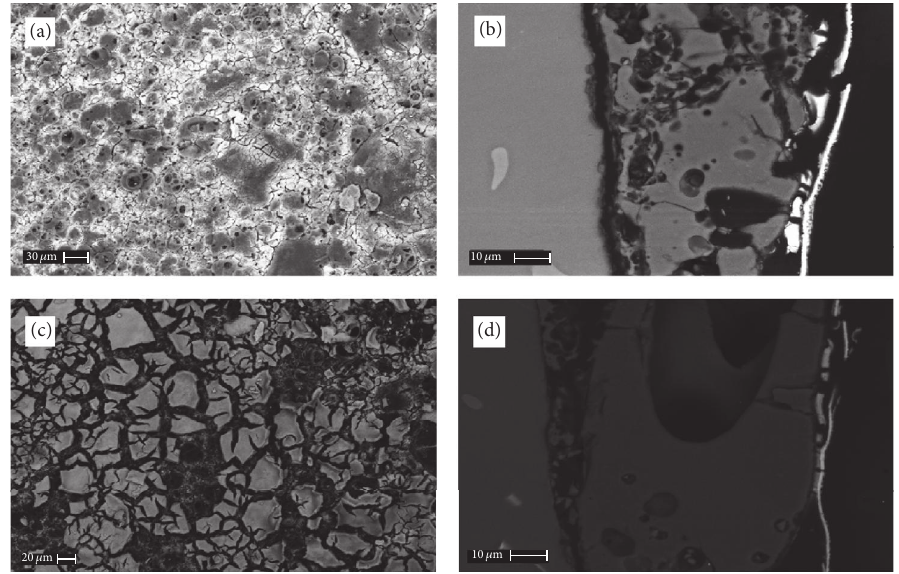
Figure 9: Scanning electron micrographs (backscattered electrons) of the surface and cross section of sealing coatings formed on AZ91 magnesium alloy with 12 g/l of La(NO 3 ) 3 at 40 ∘ C for 10 minutes (a-b) and 30 minutes